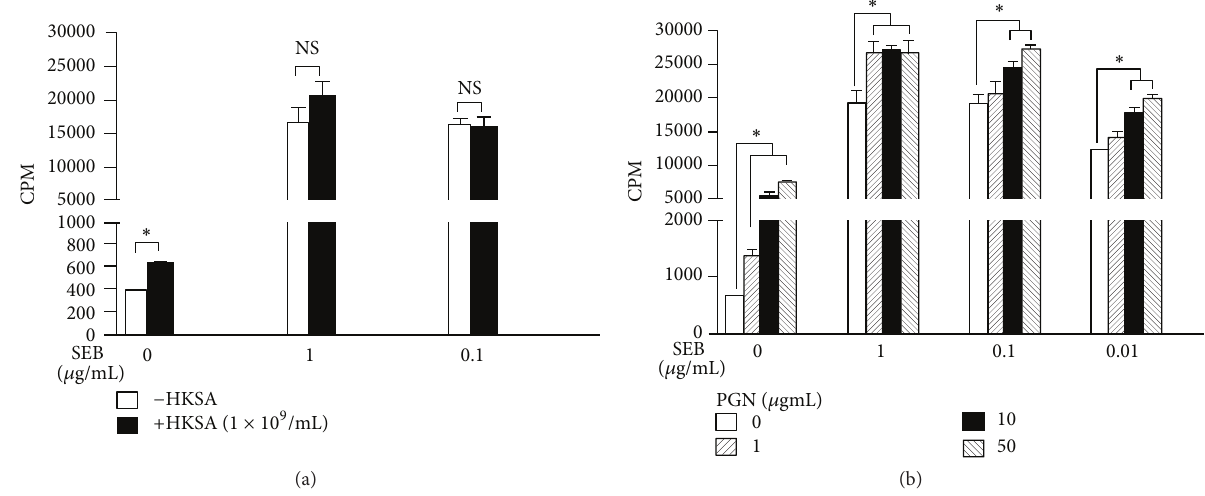
Figure3:Effectof S.aureus -derivedPAMPsonSEB-inducedTcellproliferation invitro .SplenicmononuclearcellsfromHLA-DR3transgenic mice were cultured with indicated concentrations of SEB in the presence or absence of HKSA, 10 8 bacteria/mL (a), or PGN (b). T cell proliferation was determined by thymidine incorporation. ∗ 𝑃 < 0.05 compared to cells cultured without HKSA or PGN within that group. Each bar represents mean ± SE from triplicate wells. Representative data from one out of 3 similar experiments are given.